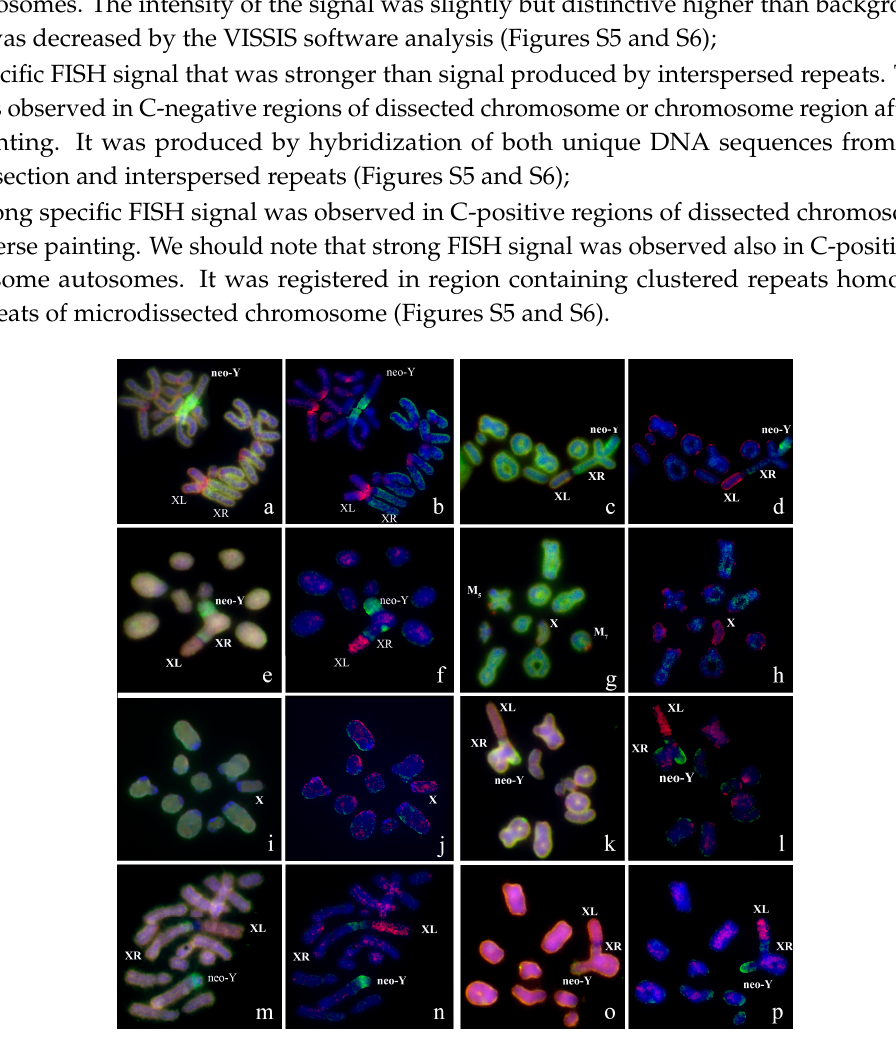
Figure 2. FISH ( a , c , e , g , i , k , m , o ) of AheXL (red) and AheYcen (green) DNA probes with meiotic chromosomes of Trinchinae species and VISSIS analysis ( b , d , f , h , j , l , n , p ) of microphotographs. XL indicates short arm of neo-X that corresponds to ancestral X chromosome, XR indicates long arm of neo-X chromosome derived from autosome fusion. Neo-Y, M 5 M 7 indicates corresponding chromosomes: ( a , b ) Asiotmethis heptapotamicus songoricus ; ( c , d ) Asiotmethis turritus ; ( e , f ) Asiotmethis limbatus ; ( g , h ) Asiotmethis muricatus ; ( i , j ) Glyphotmethis adaliae ; ( k , l ) Glyphotmethis holtzi pulchripes ; ( m , n ) Glyphotmethis efe ; ( o , p ) Glyphotmethis dimorphus dimorphus . Application of the VISSIS software improved the differentiation of signal types (Figure 2b). The determination of C-negative region of dissection after reversed painting was similar to results of CISS-hybridization in mammals but intensity of chromosome specific FISH signal in C-positive regions in original chromosome was not suppressed.